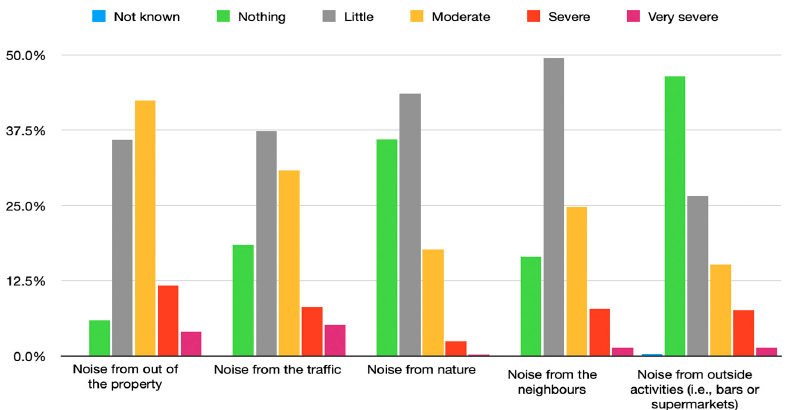
Figure 8. Frequencies regarding the description of the noise before lockdown.